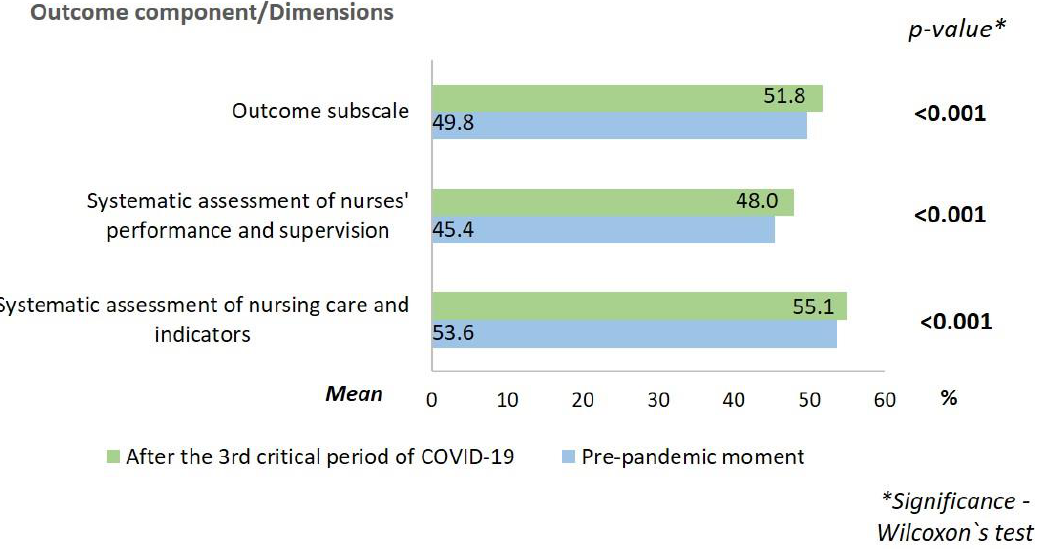
Figure 3. Mean scores of the outcome component of nursing professional practice environments at the pre-pandemic moment and after the 3rd critical period of COVID-19.